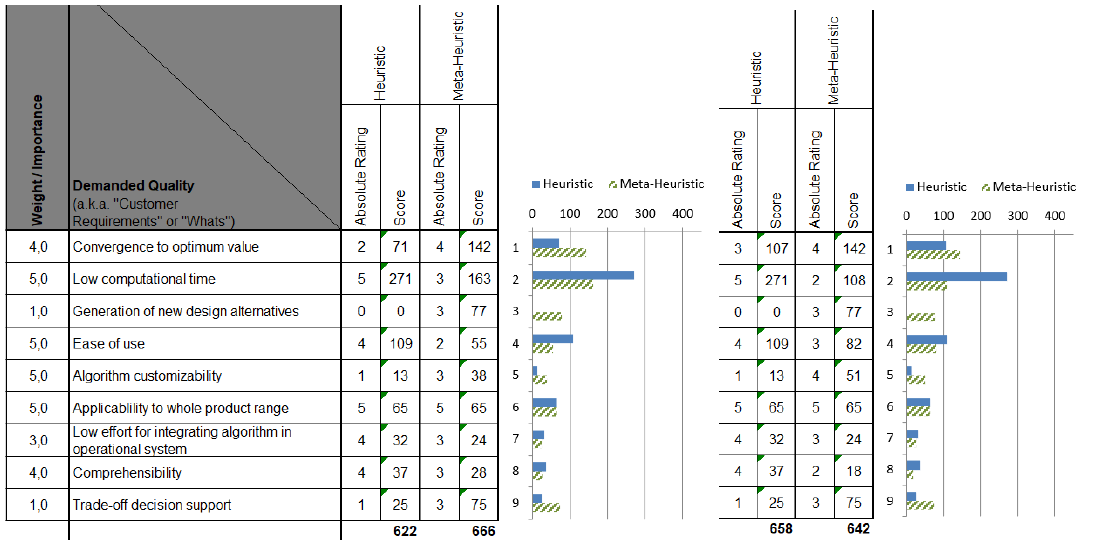
Figure 7. Decision Matrix for Boom Configuration before optimization (( left ) with Demanded Quality Criteria) and after optimization ( right ). Note that, for a better representation, only the scoring for comparing the algorithms are